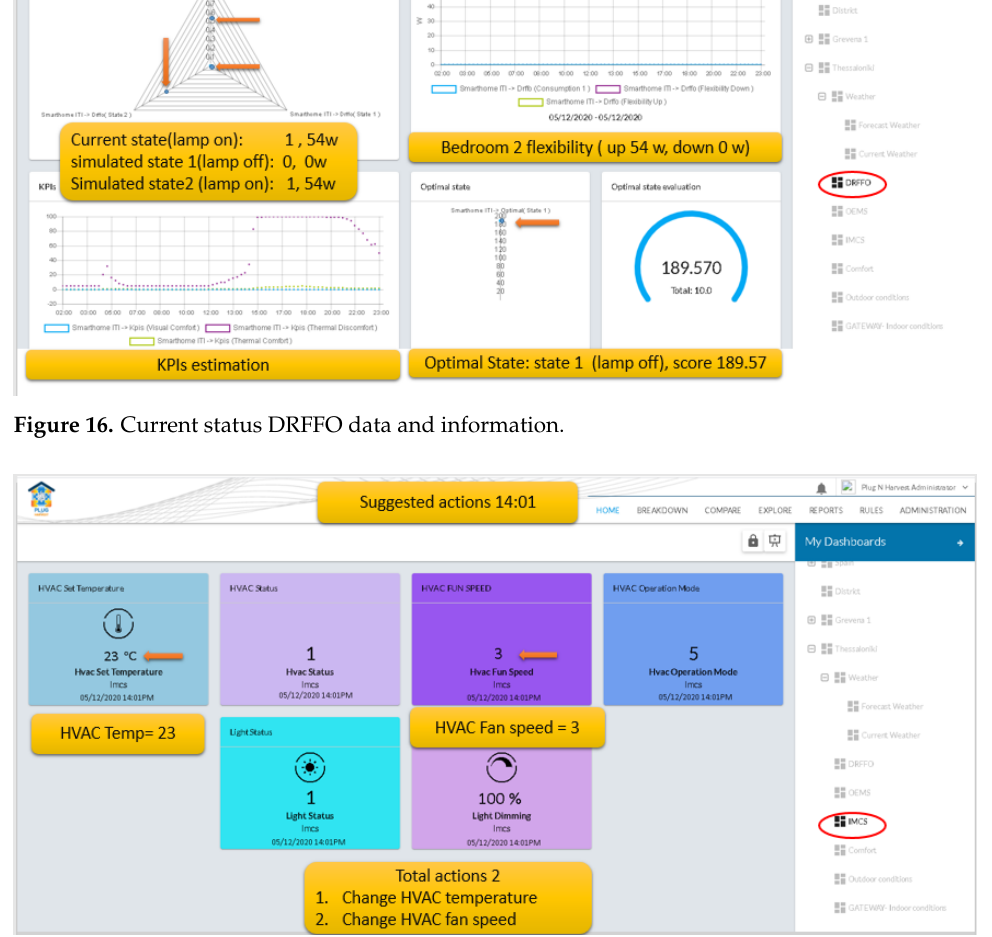
Figure 17. IMCS suggested